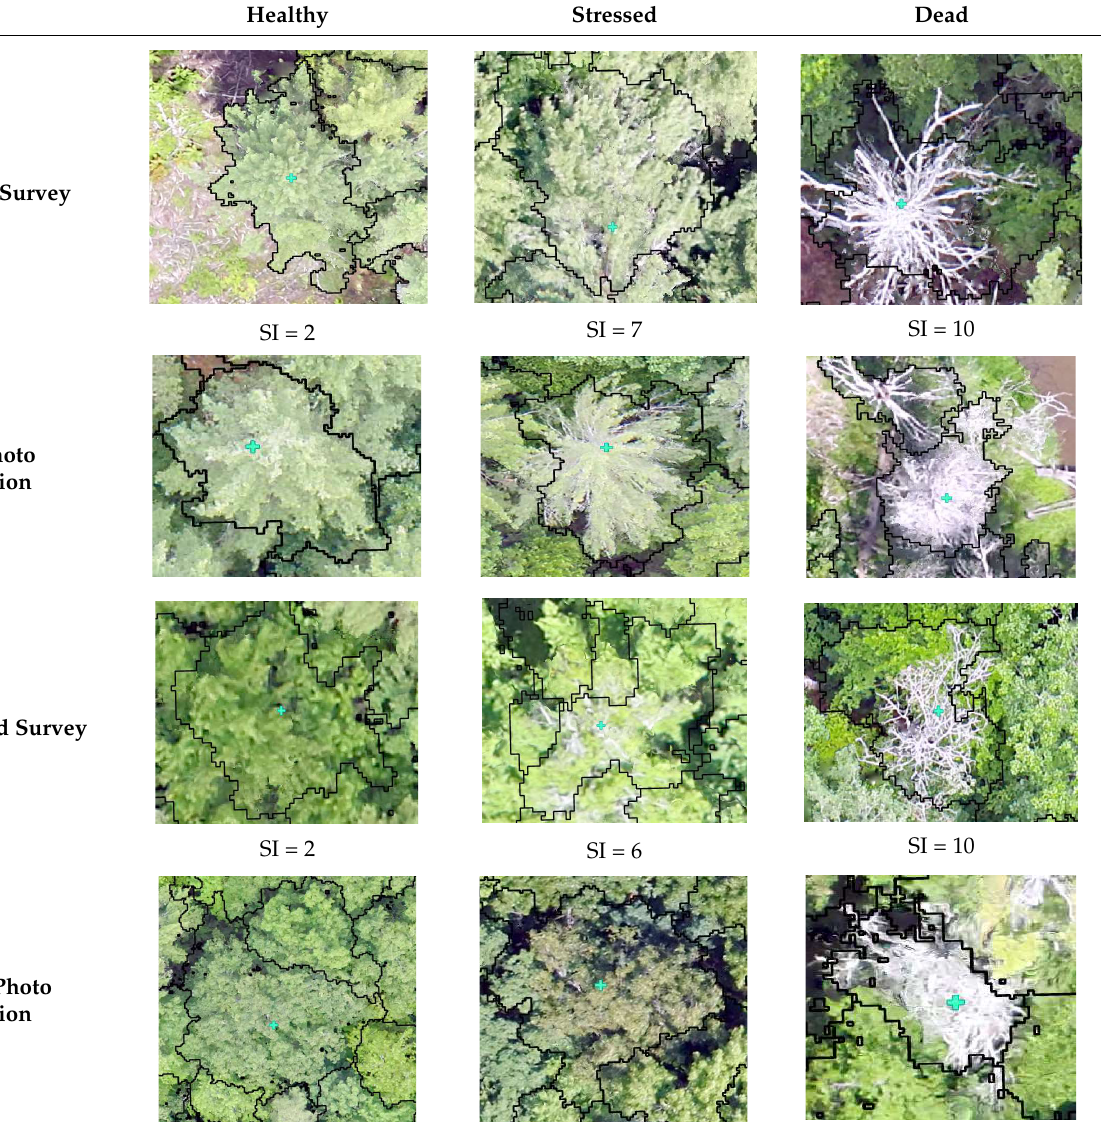
Table A1. Reference samples collected for forest health survey classes using both field methods and photo interpretation. Both coniferous and deciduous trees of the ‘Healthy’, ‘Stressed’, and ‘Dead/Degraded’ classes collected as reference data using both sampling methods are provided as a guide to their similarity.